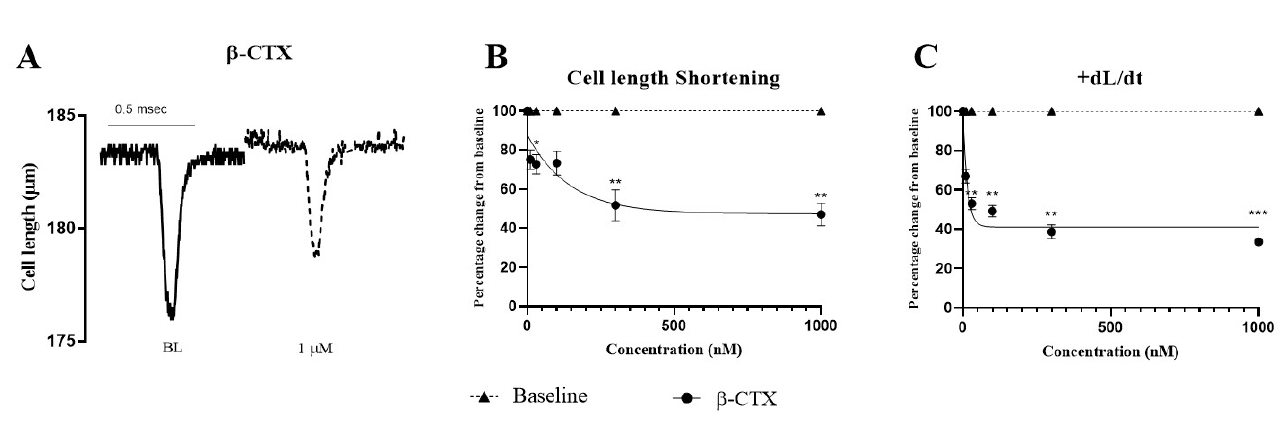
Figure 3. Effects of β-CTX on isolated cardiomyocyte inotropy. (A) Original recordings of cell length compared to baseline (BL) and following application of 1 µM β-CTX. Non-linear curve fits of (B) cell length shortening and (C) cell shortening velocity (+dL/dt) normalized to baseline data as function of toxin